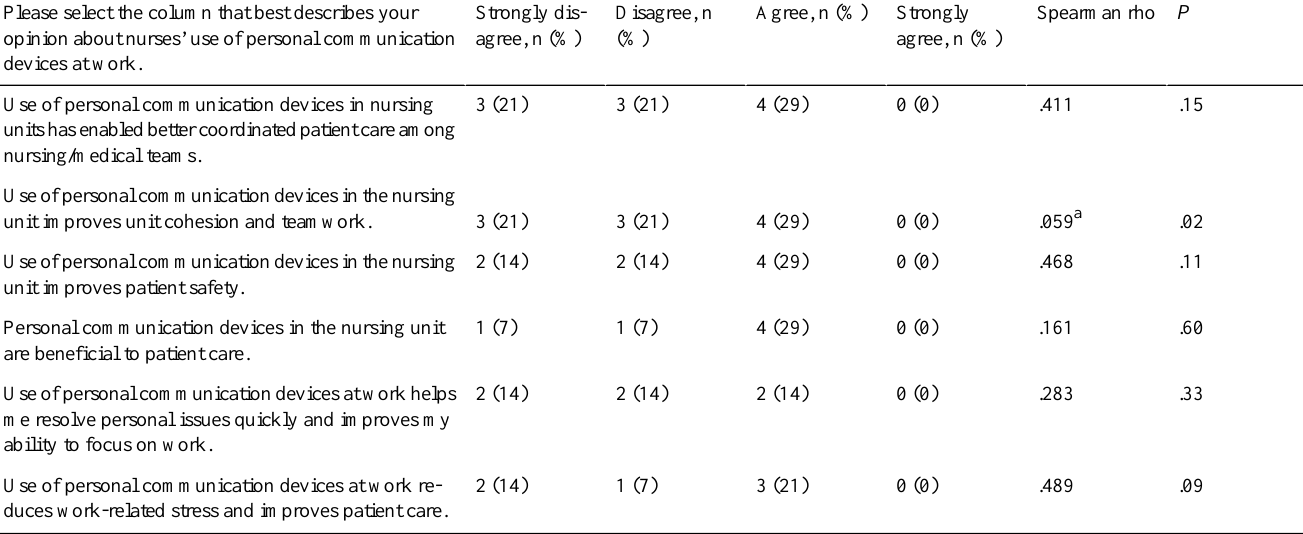
Table 4. Respondents with the same answers to both online pilot surveys for Group 3: impact scale.